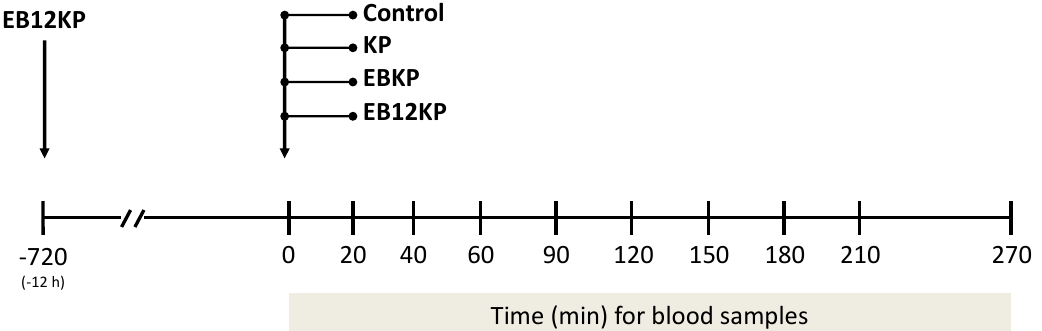
Figure 1. Study design. Ovariectomized Nelore cows ( n = 8) were used in a Latin square design and received the following treatments: Control, i.m. 4 mL 0.9% saline; KP, i.m. 4 mg murine KISS1-10 in 4 mL 0.9% saline; EBKP, i.m. 4 mg KISS1-10 + i.m. 2 mg estradiol benzoate (EB) simultaneously; EB12KP, i.m. 2 mg EB 12 h before i.m. 4 mg KISS1-10. Blood samples were obtained at 0, 20, 40, 60, 90, 120, 150, 180, 210, and 270 min relative to the time of treatment.